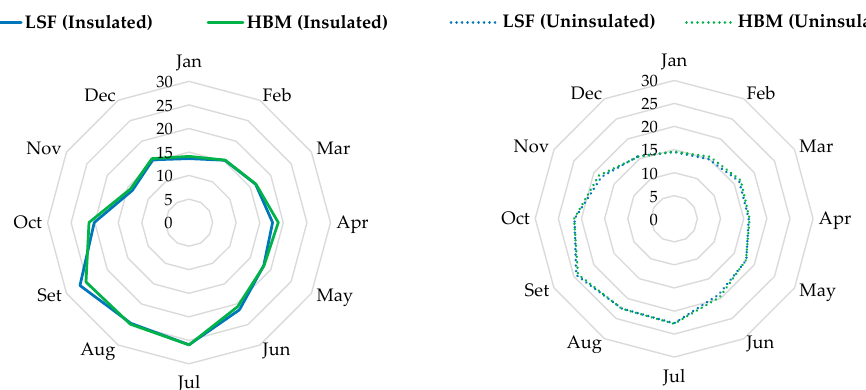
Figure 8. Monthly median indoor air temperature for the insulated and uninsulated experimental setups (°C).